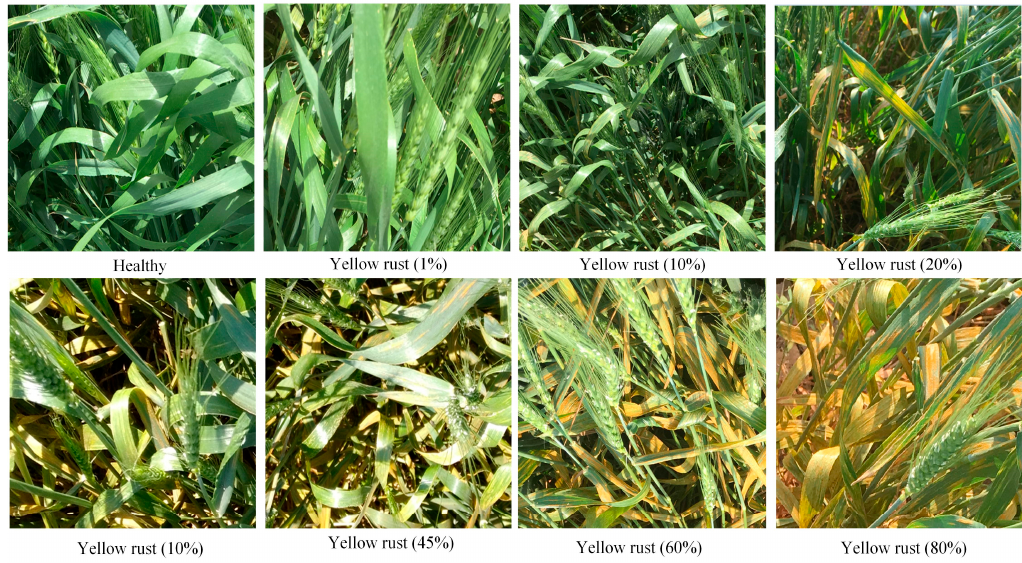
Figure 3. Photos of healthy and different incidences of yellow-rust-infected winter wheat canopies.